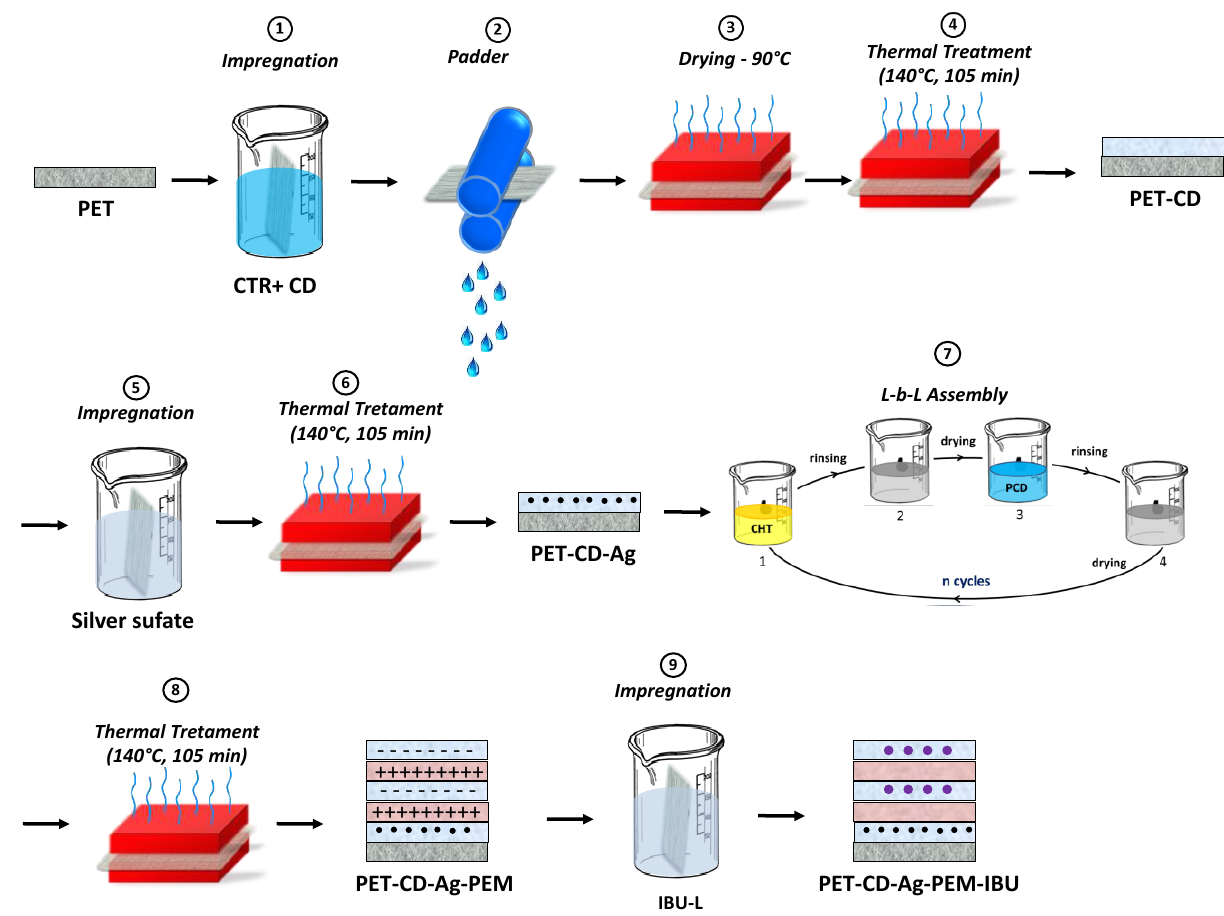
Figure 1. Schematization of preparation of PET-CD-Ag-PEM-IBU. In order to remove the sizing agent, raw PET textile supports were preliminarily washed three times by Soxhlet extractor with isopropanol (3 h) and rinsed three times with ultrapure water, then dried during 15 min at 90 ◦